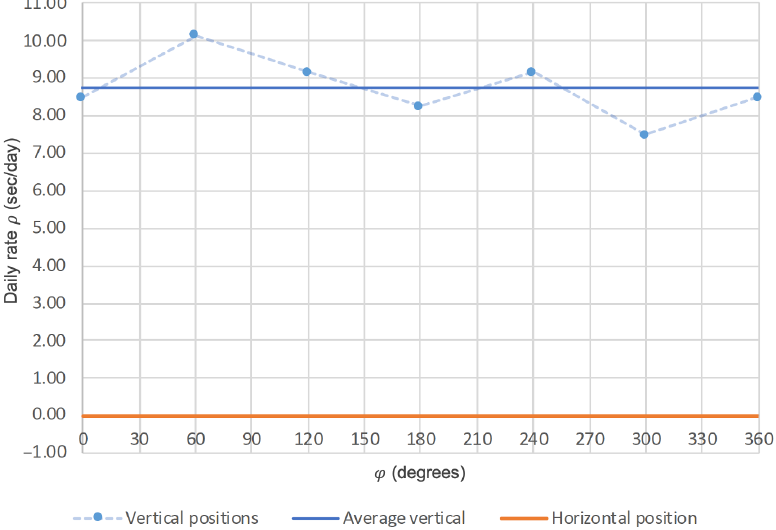
Figure 4. Daily rate ρ of the watch-scale silicon TRIVOT oscillator for varying angle ϕ of the gravity load in the oscillation plane (vertical positions) and for gravity acting along the rotation axis (horizontal position).